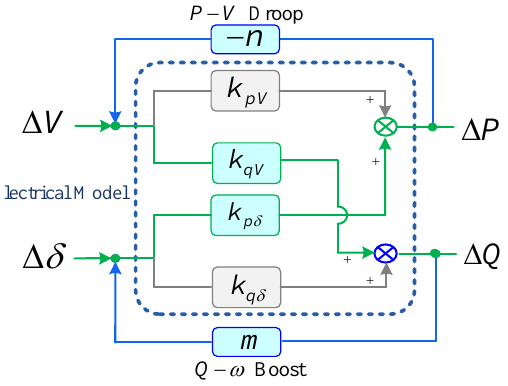
Figure 23. The whole small signal model in pure inductive line of AC microgrid.